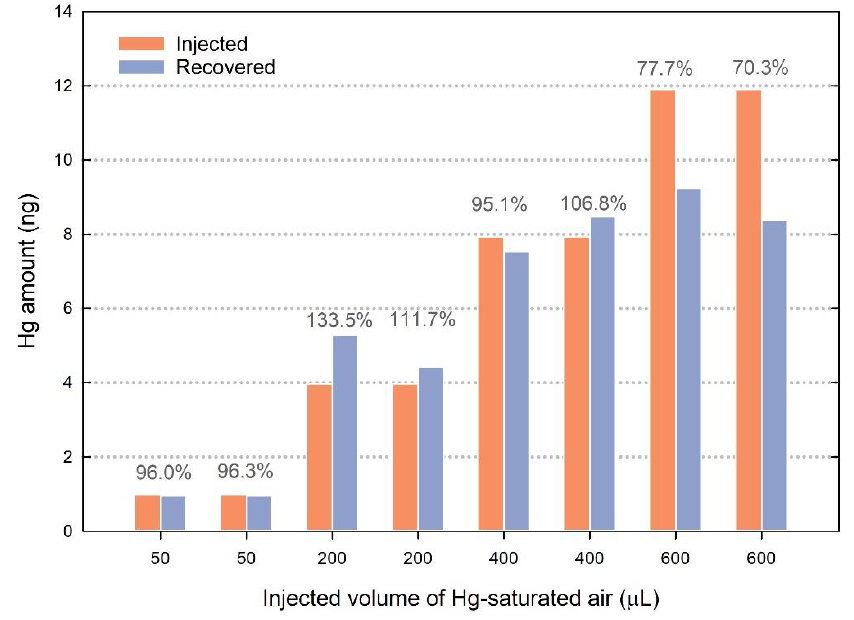
Figure 3. Injected and recovered Hg amount for the gold-coated beads. The gray numbers above the bars represent the recovery rates.